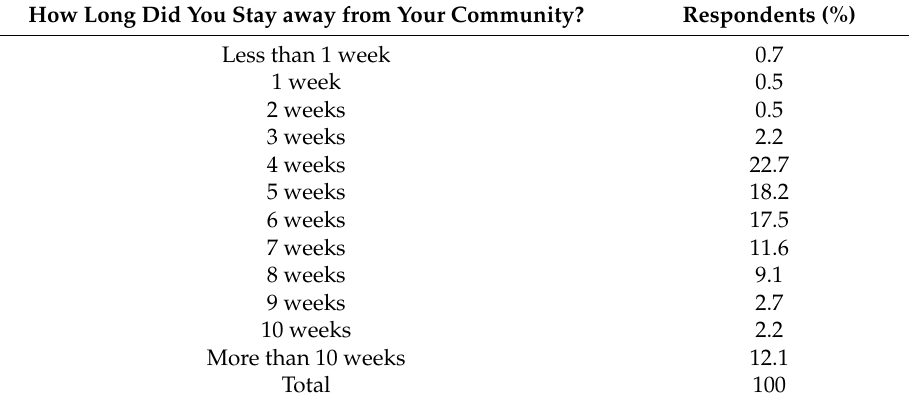
Table 7. Length of stay elsewhere (n =